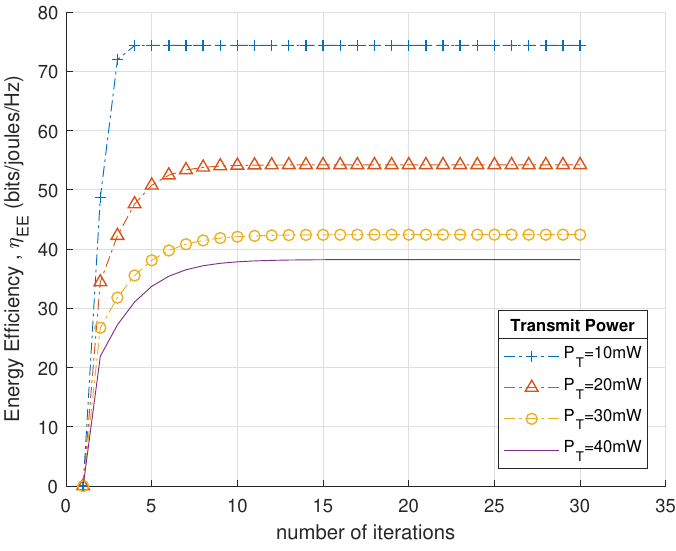
Figure 6. EE with respect to transmit power.